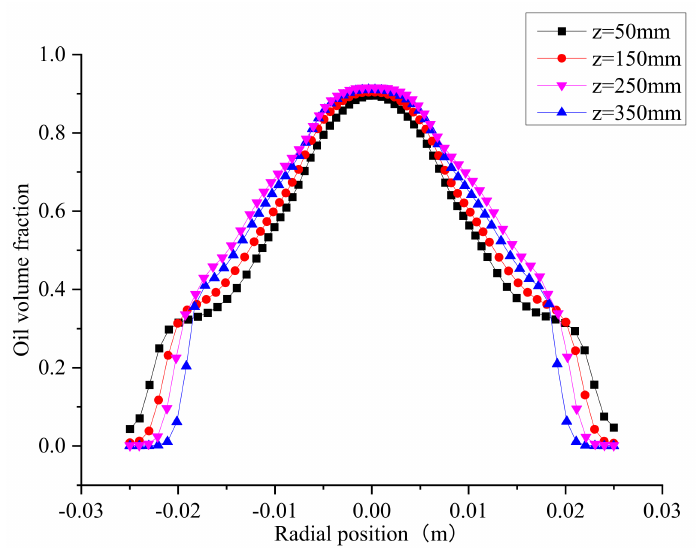
Figure 16. Radial distribution curves of oil concentration in different cross